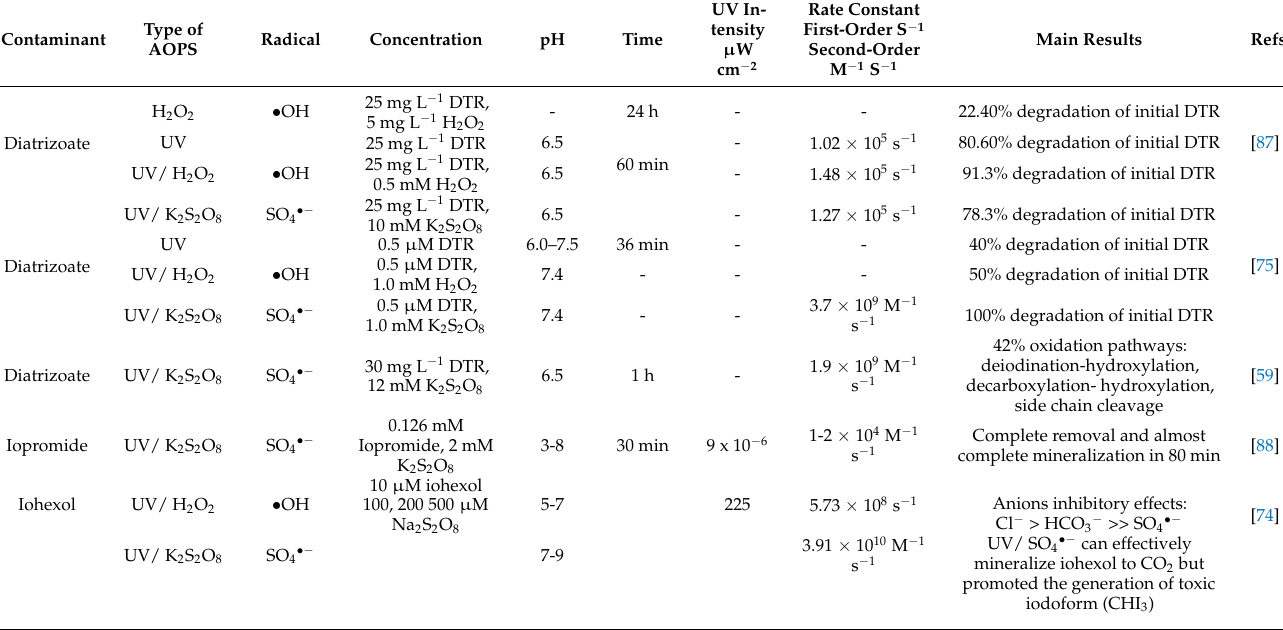
Table 3. Examples on the treatment of ICM by UV based